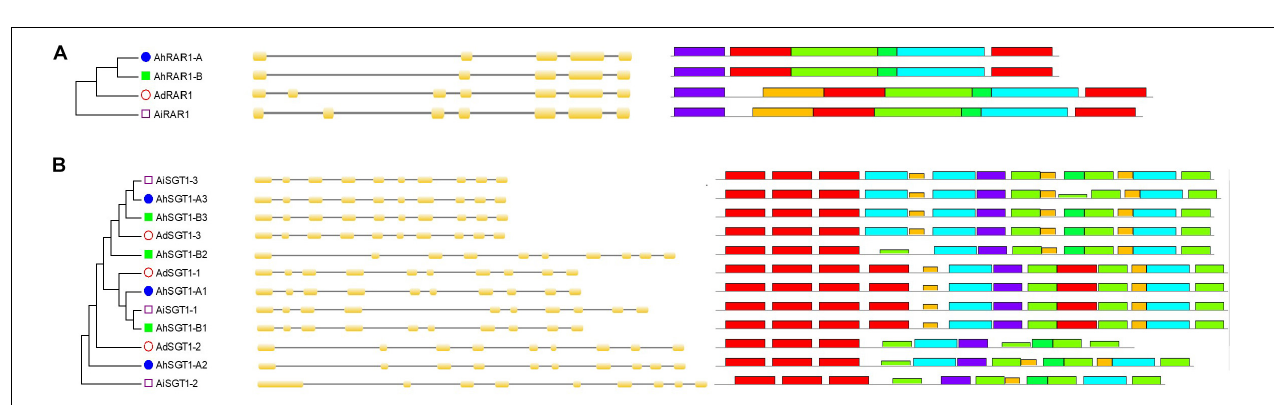
FIGURE 5 | Phylogenetic analysis, gene structures, and conserved motifs of the Arachis RAR1 and SGT1 genes. (A) Arachis RAR1 genes; (B) Arachis SGT1 genes.